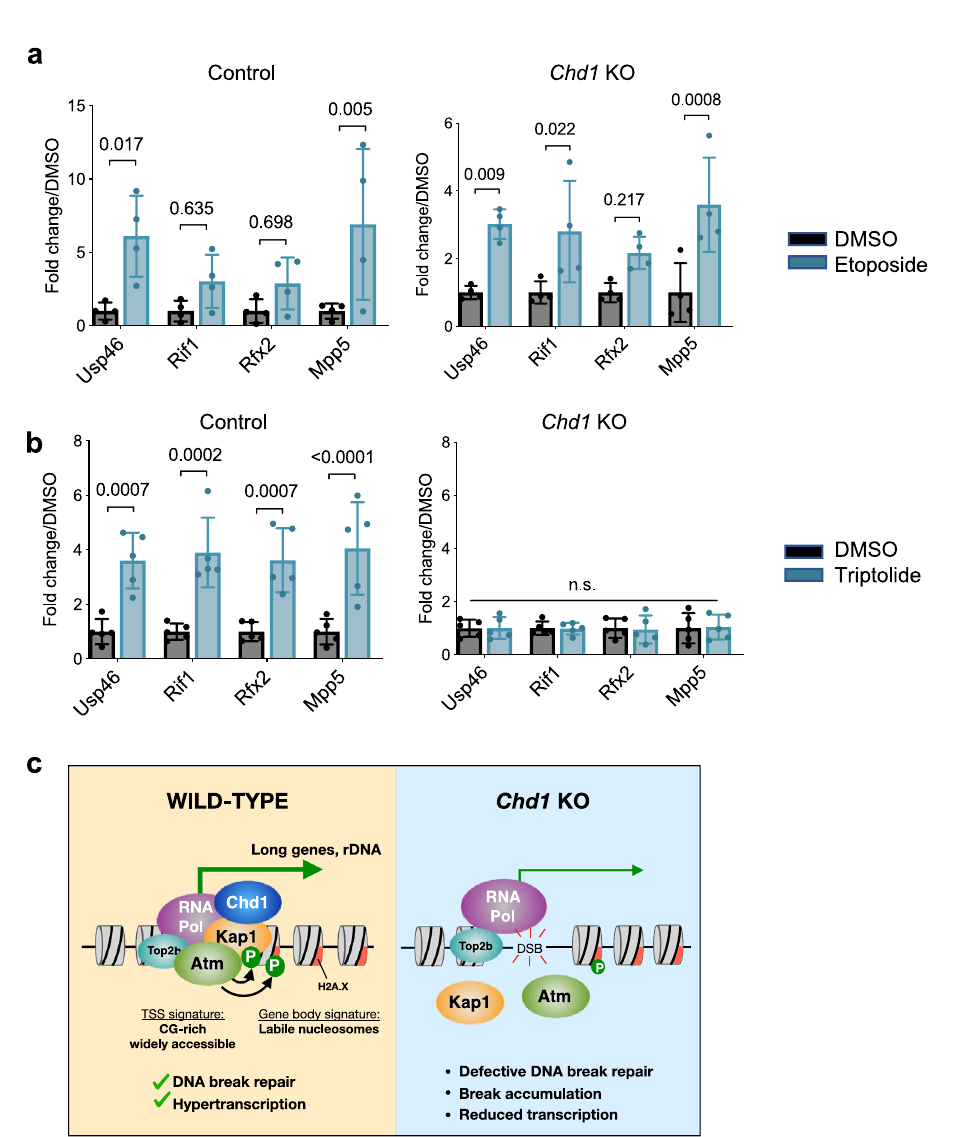
Fig. 5 Promoter-proximal DSBs occur independent of transcription initiation but are dependent on topoisomerase activity. a Gene promoter DSB levels in control and Chd1 KO cells with or without treatment of etoposide. N = 4 biologically independent experiments. Graphs show mean and standard deviation. Statistical tests performed are two-way ANOVA with Sidak ’ s correction. Values above bars indicate p -values. b Gene promoter DSB levels in control and Chd1 KO cells with or without treatment of triptolide. N = 4 biologically independent experiments. Graphs show mean and standard deviation. Statistical tests performed are two-way ANOVA with Sidak ’ s correction. Values above bars indicate p -values. c Proposed model for how Chd1 may protect genome integrity at transcribed promoters by preventing DNA break accumulation during hypertranscription in ES cells. See text for details.